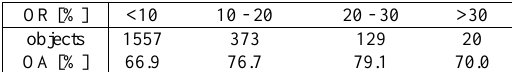
Table 4: OA as a function of the occupation ratio (OR); objects: number of objects in the respective